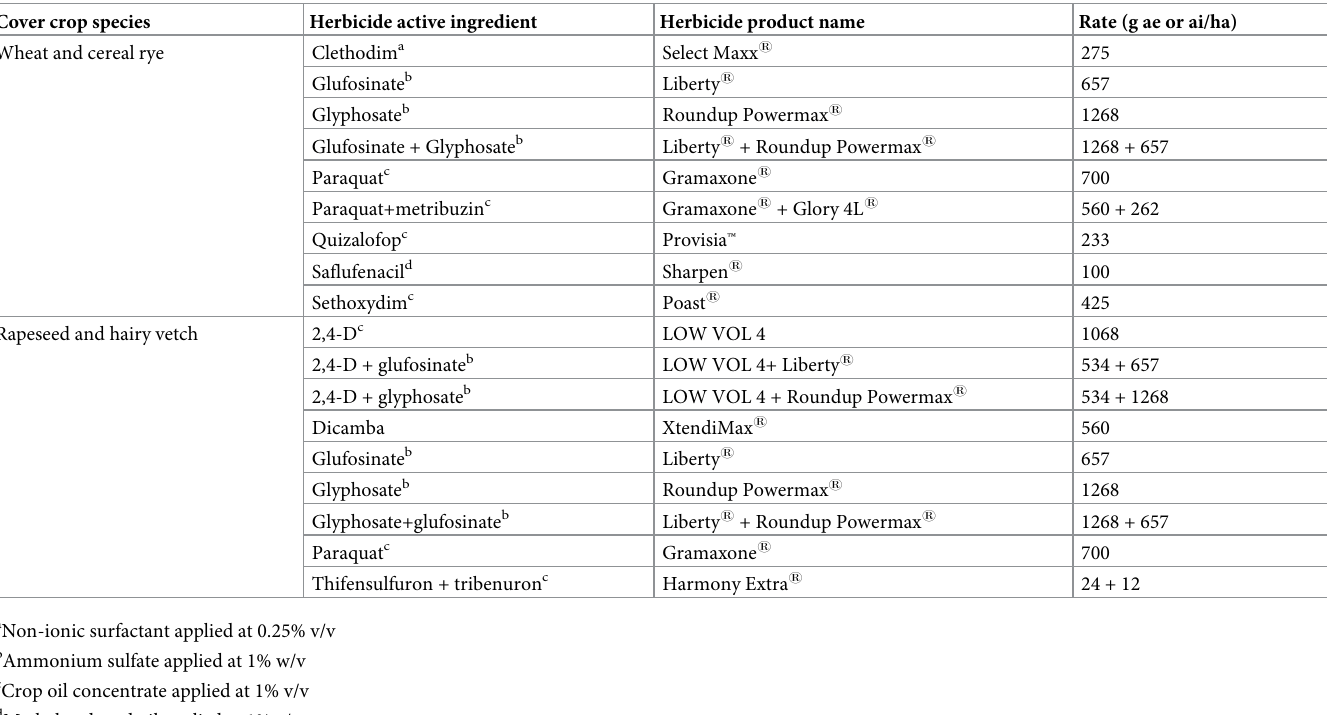
Table 2. Herbicide product names, and rates used for termination of respective cover crop species. Adjuvants added with respective herbicides are shown in footnotes. Cover crop